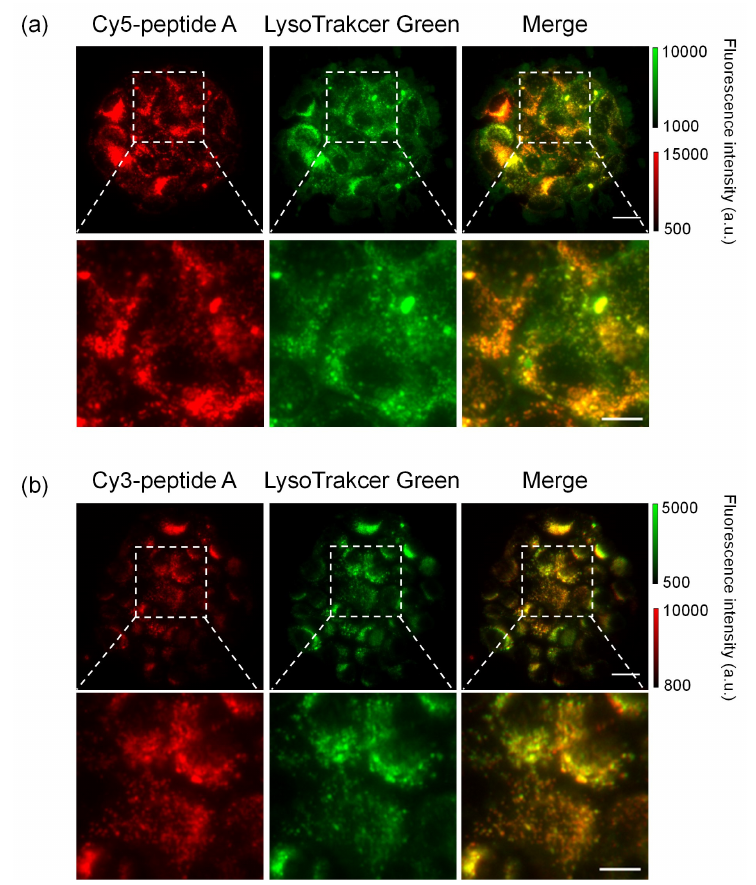
Figure 3. Colocalization of dye-peptide A and LysoTracker Green. ( a ) Cy5-peptide A, ( b ) Cy3-peptide A. Scale bar: 10 µ m, 5 µ m for magnified